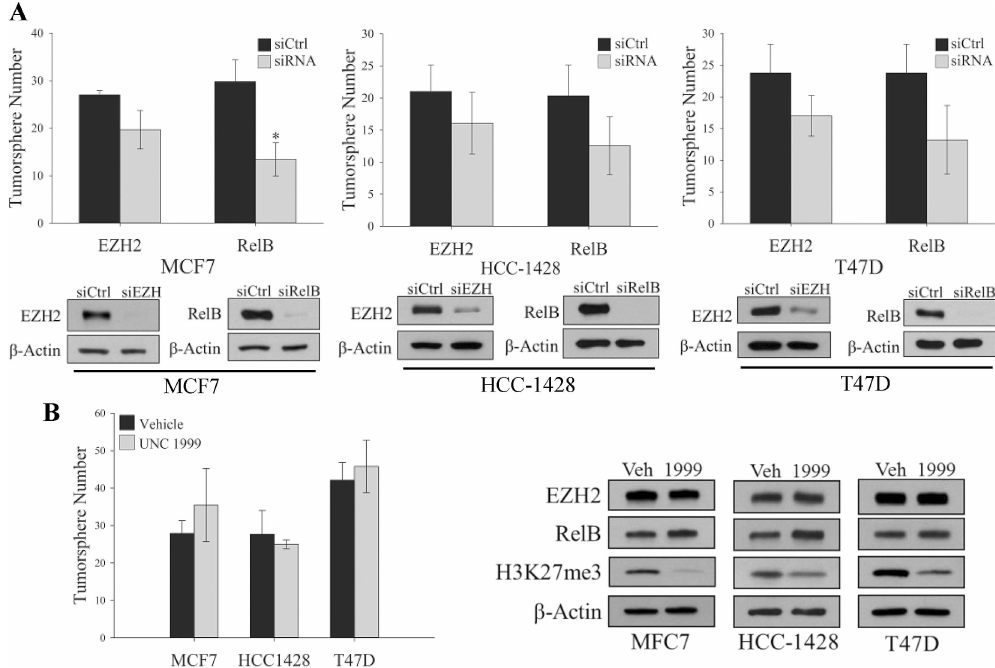
Fig 2. Self-renewal of TICs in ER+ Breast Cancer Cells is not Dependent on EZH2 and RelB. (A) Top Panel, Quantification of tumorspheres formed by 100 MCF7, HCC-1428or T47D cells expressing control siRNA or siRNA targeting EZH2 or RelB. Values given as means ± standard deviationfrom three biologicalrepeats. * P < 0.05 versus controls; two tailed unpairedt-test. Bottom Panel, Immunoblots of indicatedproteins in adherent MCF7, HCC-1428 or T47D cells expressingindicted siRNA construct. β -actin serves as a loadingcontrol. (B) Left panel, quantification of tumorpsheres formed by 100 MCF7, HCC-1428 or T47D cells treated daily for 3 days with 1 μ M UNC1999.Values given as means ± standard deviationfrom three biologicalrepeats. Right panel, immunoblots of the indicatedproteins in adherent MCF7, HCC-1428 or T47D cells treated daily for 3 days with 1 μ M UNC1999 to validate EZH2 inhibition. β -actin serves as a